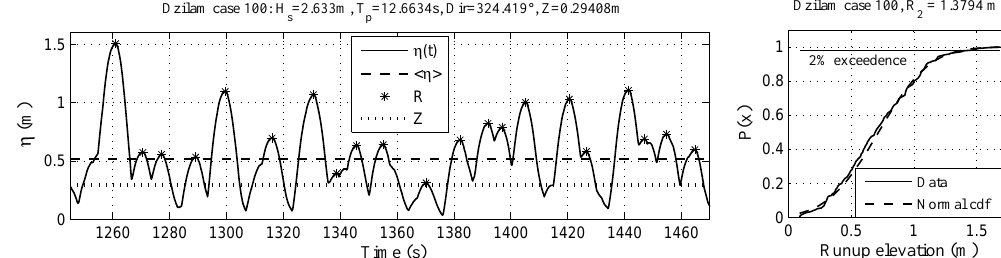
Figure 6. Section of water level elevation time series relative to mean sea level ( η(t) ) extracted from the wet–dry boundary of SWASH simulations for every sea state propagated to shore, indicating tide Z , run-up maxima, R , and setup at the shoreline < η > (left panel). The 2% exceedance value was extracted from the cumulative distribution function (cdf) of the R values (right